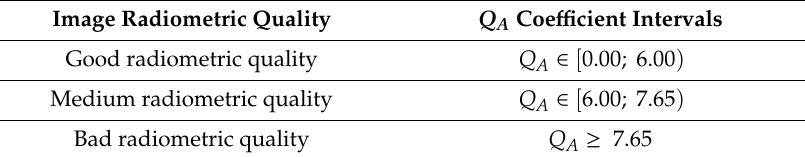
Table 2. Classification of radiometric quality by Q A coe ffi cient